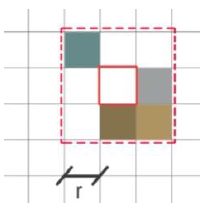
Figure 10. Search matrix used to correct for lack of data. The search radius r is normally set to 1.